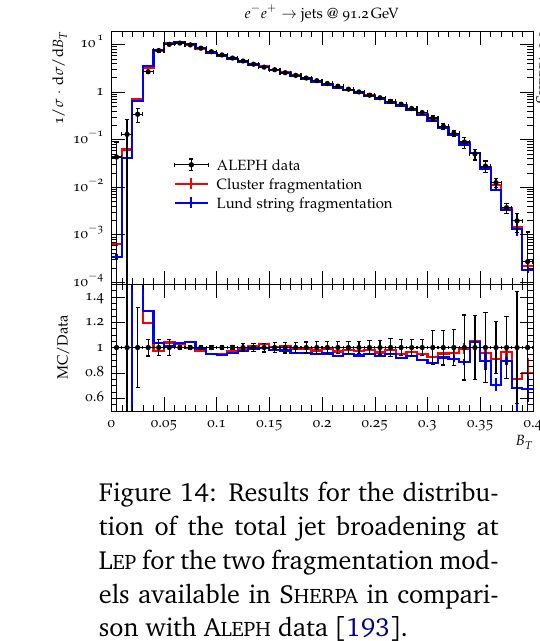
Figure 13: Results for the thrust distribution in jet production at L EP for the two fragmentation models available in S HERPA in comparison with A LEPH data [ 193 ] .